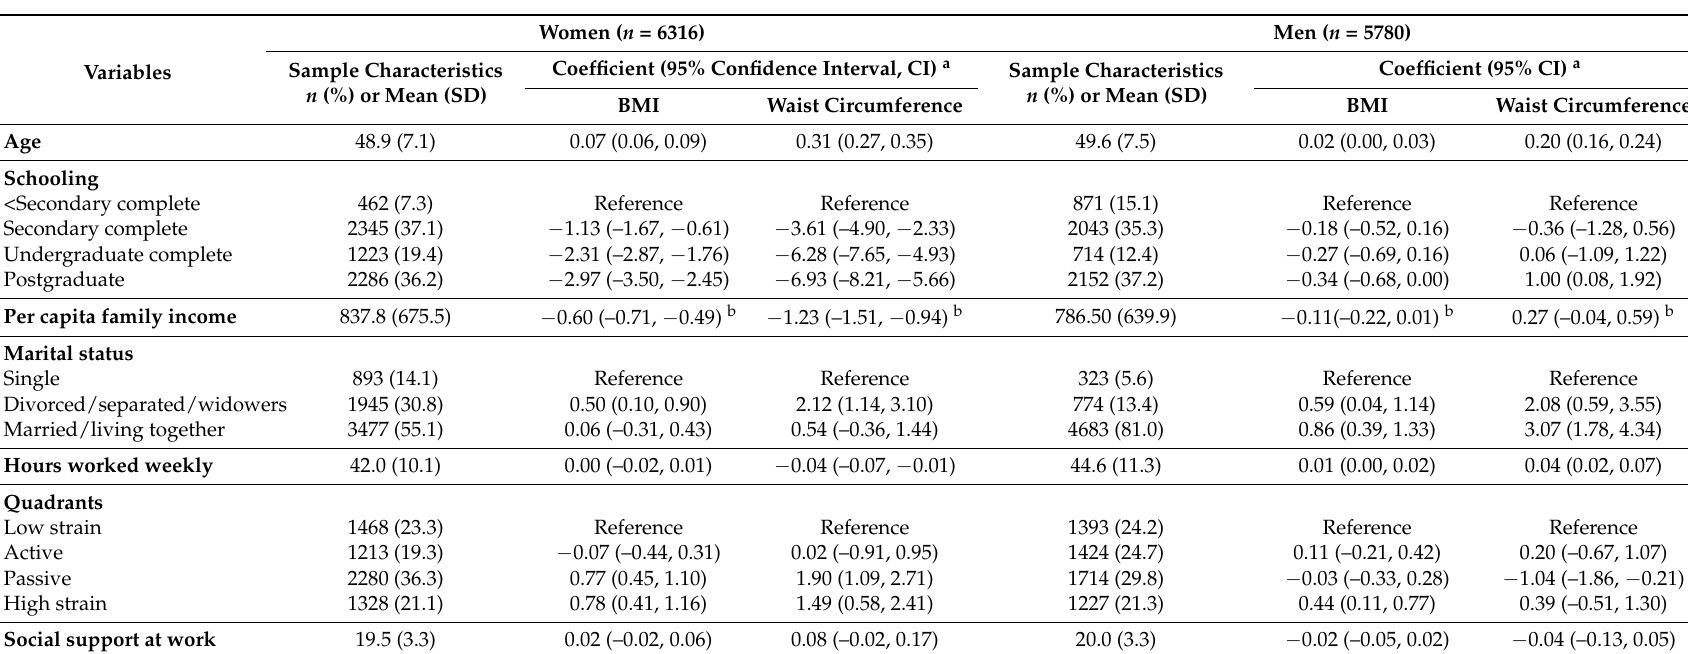
a Unadjusted analysis using gamma regression. b Coefficients for standardized per capita family